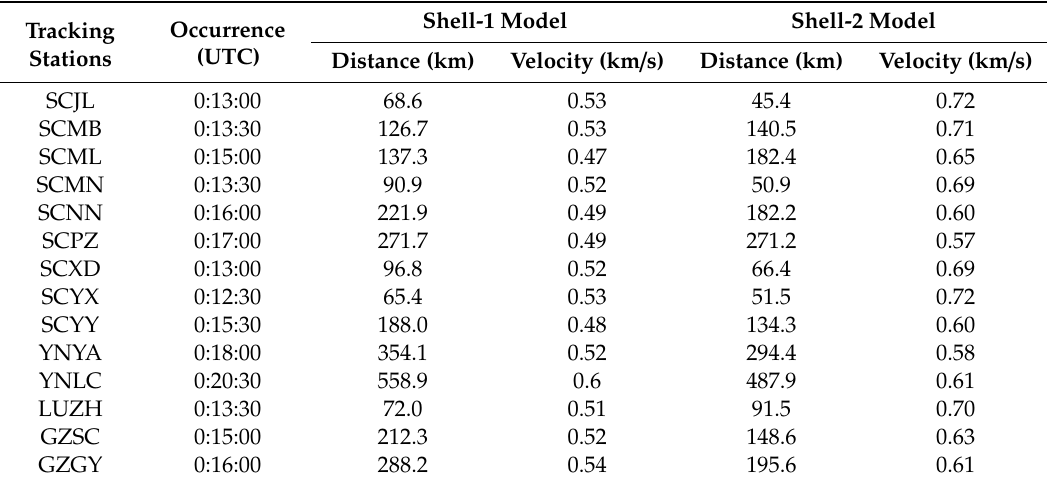
Table 1. Statistics of CIDs in di ff erent shell models.